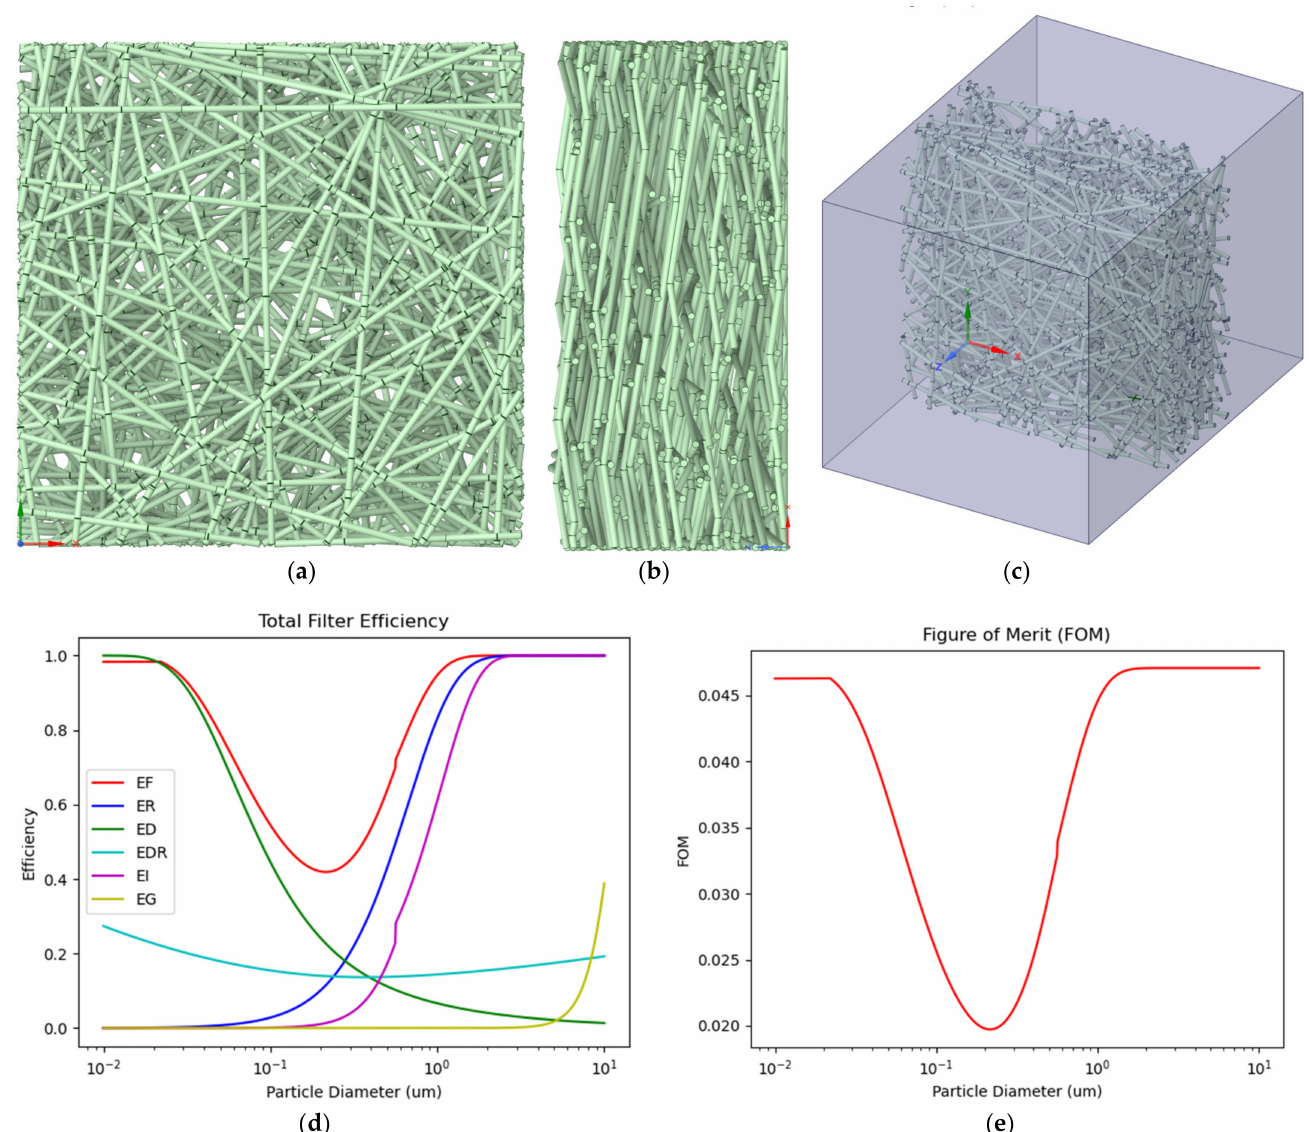
Figure 10. Analytical modeling of digital twin. ( a ) Top view of face area perpendicular to flow. ( b ) Side view showing filter thickness. ( c ) Geometry loaded into enclosure for CFD modeling. ( d ) Total filter efficiency shown by SFE model components. ( e ) Resulting Figure of